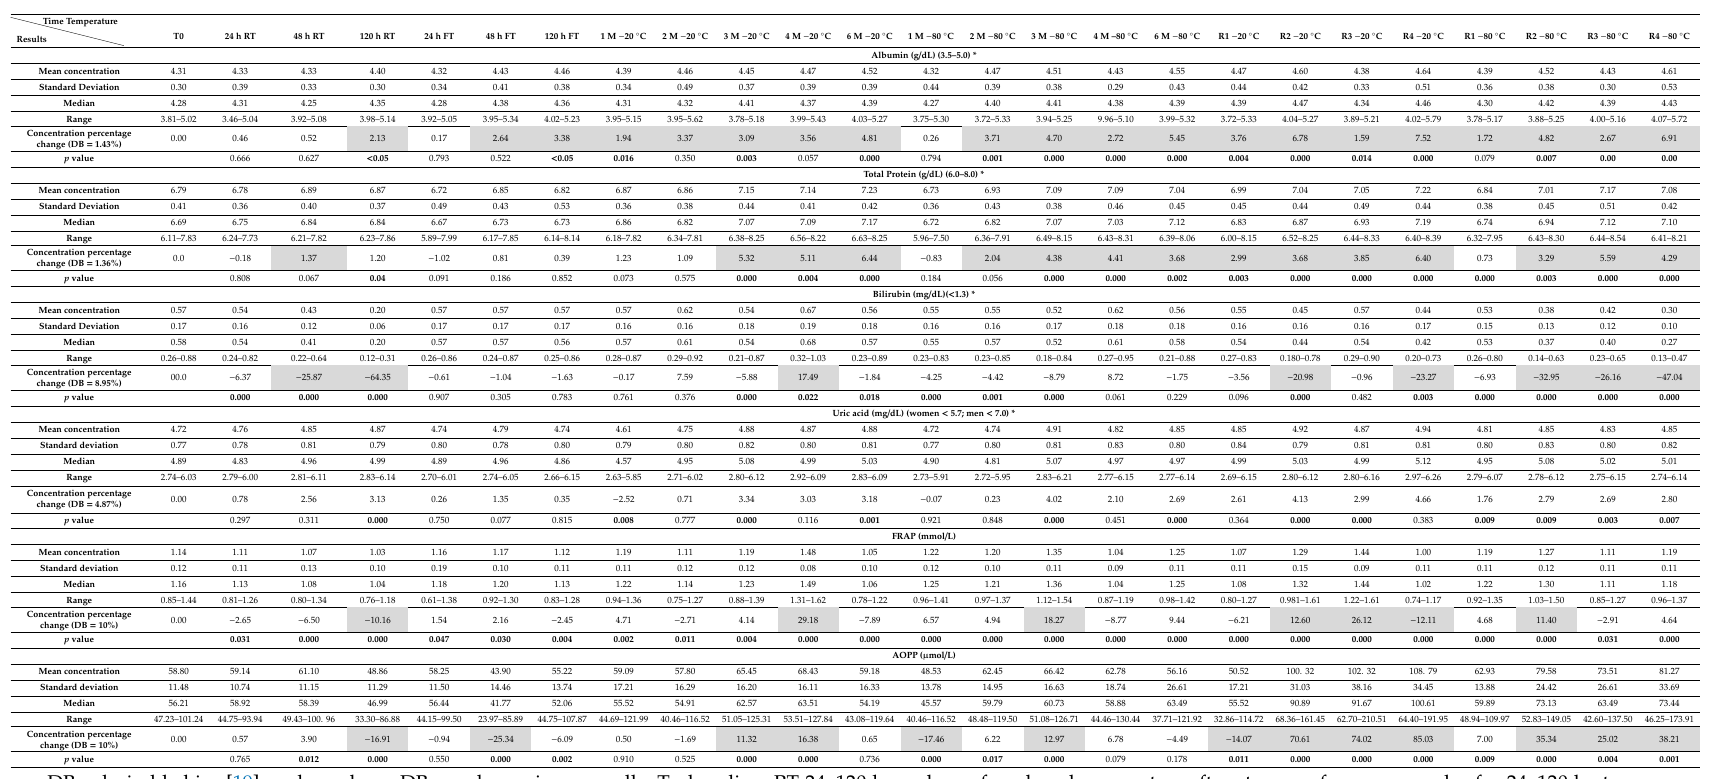
Table 2. Behavior of chosen parameters after serum sample storage in various